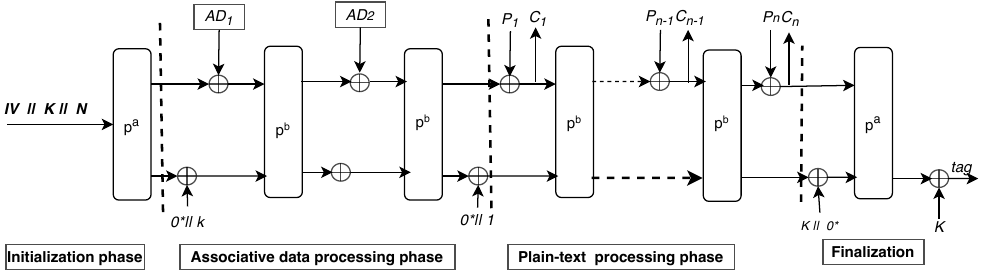
Figure 2. ASCON architecture.